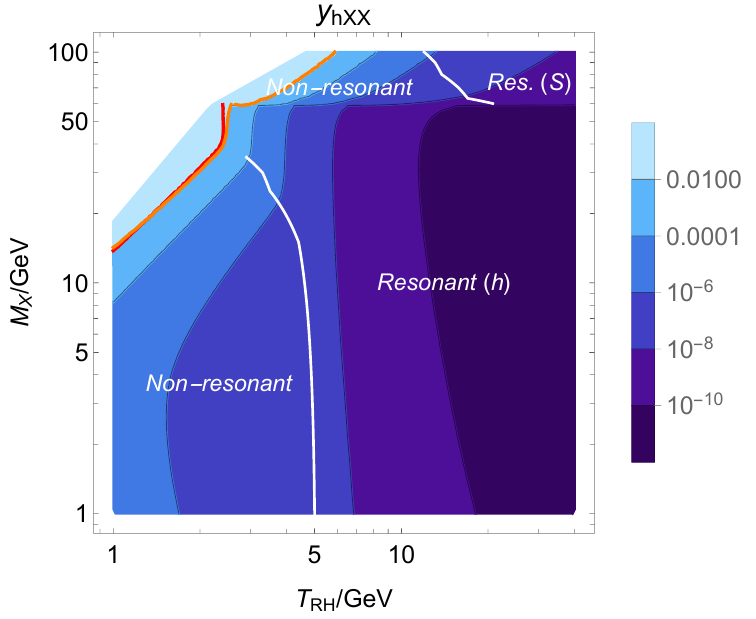
Figure 3 . Contours of the Higgs-DM coupling ( y hXX ) needed to produce the measured DM relic abundance, as a function of the reheat temperature and of the DM mass for m S = 500 GeV and sin θ h = 0 . 1 . The white region corresponds to y hXX > 1 . The white curves separate regions of parameter space where different contributions dominate dark matter production, as specified by the labels. The red curve represents the LHC bound on Higgs invisible decays (see section 5.1.1), whereas the orange curve represents the constraints from current direct detection data from XENON1T [36] (see section